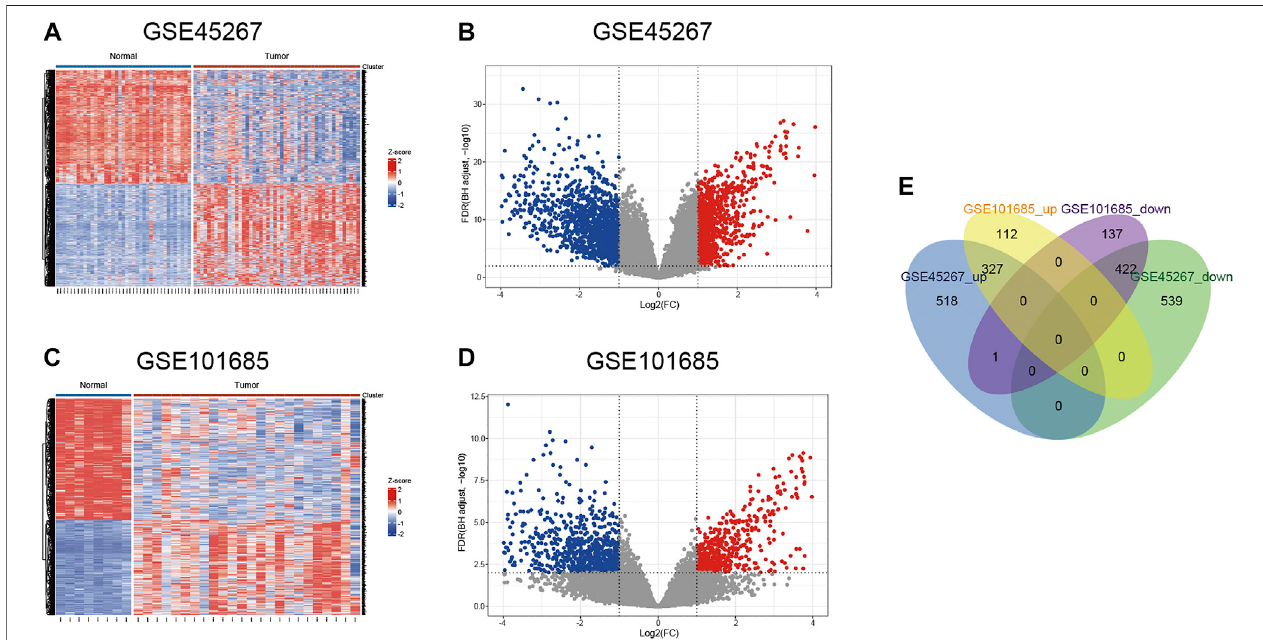
FIGURE 2 | Identi fi cation of differentially expressed genes. (A,B) Heat map and volcano plot of the GSE45267 dataset. (C,D) Heat map and volcano plot of the GSE101685 dataset. (E) Venn diagram of the common upregulated and downregulated DEGs. DEGs, differentially expressed